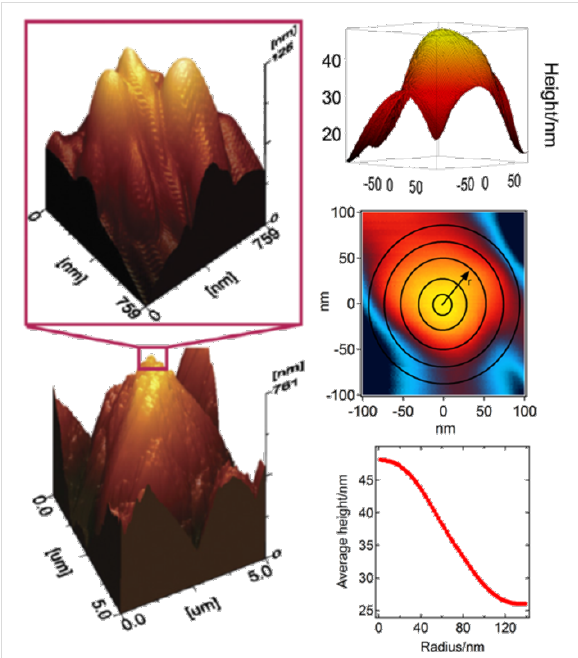
Figure 3: Left: Sub-micrometer protrusions on the pyramids of the multi-scaled rough diamond surface; reproduced with permission from [26], copyright 2013 Elsevier. Right: (top, middle) Typical sub-microm- eter protrusion topography obtained with AFM, with the average height as a function of the peak radial distance in the lower right panel.